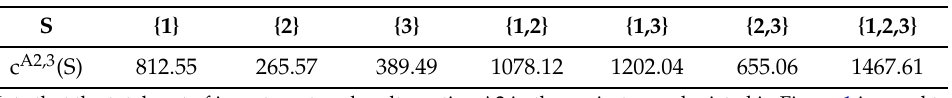
Table 6. Additive cost (LE) in Game c A2,3